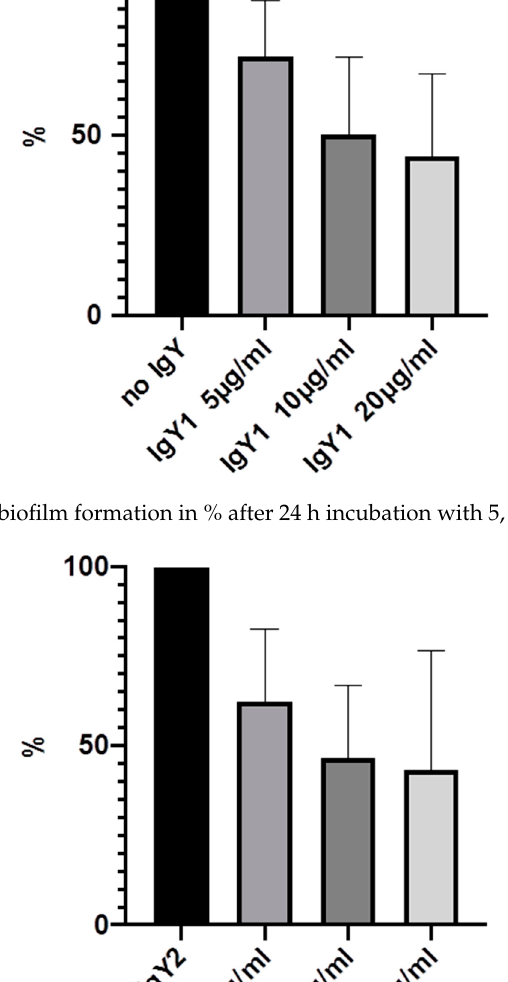
Figure 4. Inhibition of biofilm formation in % after 24 h incubation with 5, 10 and 20 µg/mL IgY2.